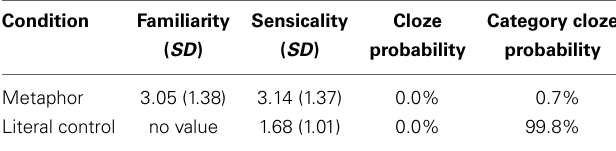
Table 1 | Summary of mean values from pre-tests for selected metaphors and corresponding literal